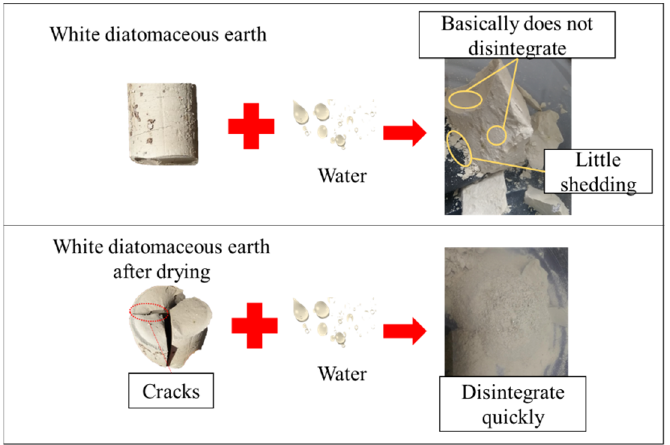
Figure 3. Natural diatomaceous earth and natural diatomaceous earth after shade-drying to observe the phenomenon of water